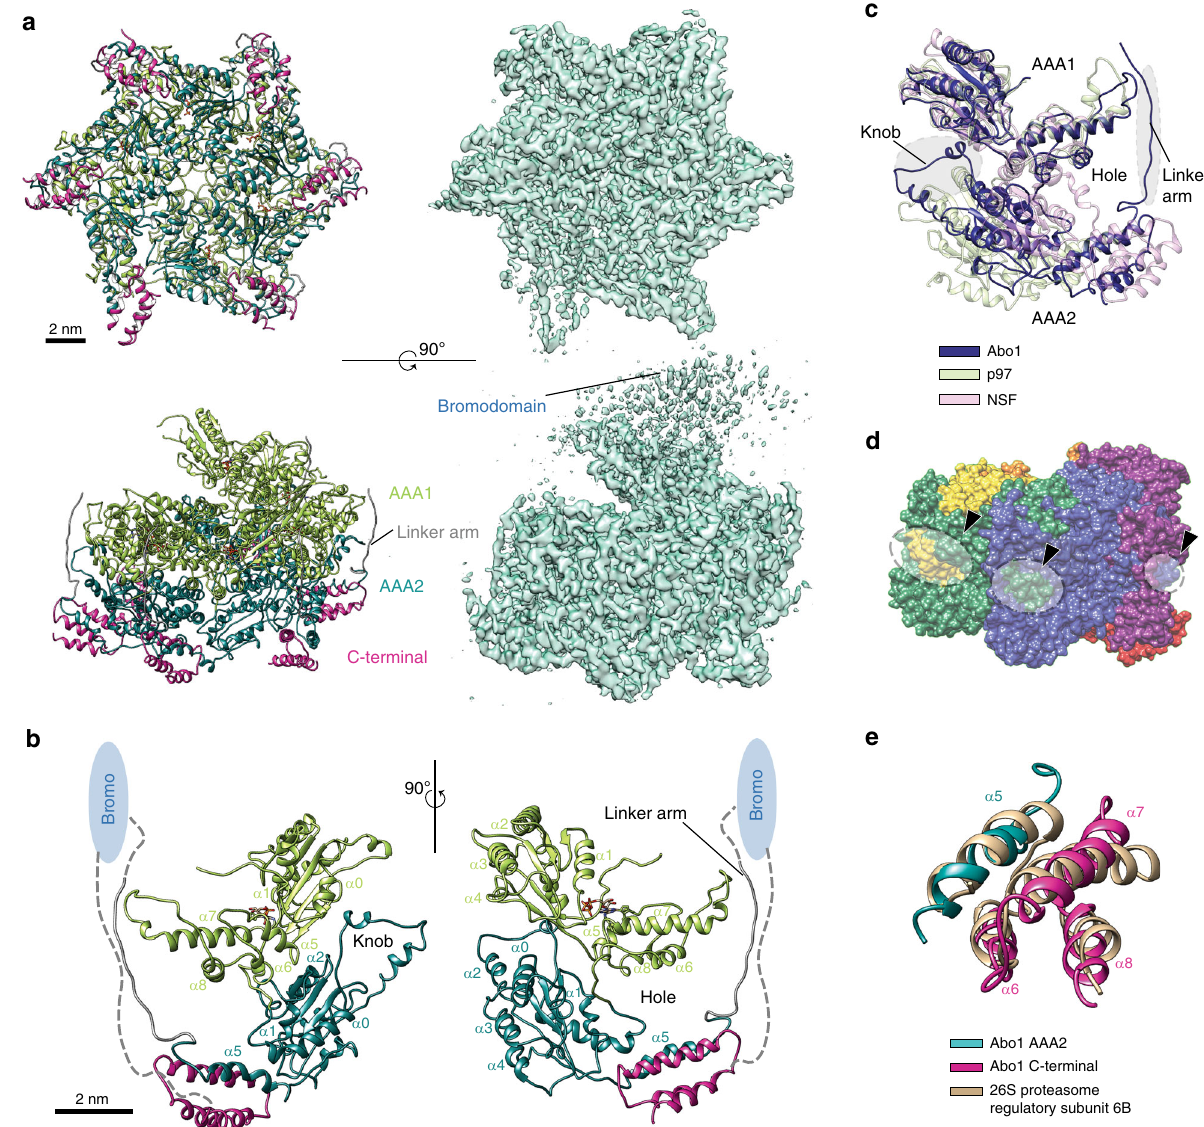
Fig. 3 Cryo-EM structure of Abo1-Walker B mutant in the ATP state shows unique AAA + structural organization. a An atomic model (left) and cryo- EM map (right) of ATP-Abo1 Walker B mutant viewed from “ bottom ” (AAA2 side, top panel) and “ side ” of the AAA + ring (bottom panel). The AAA1 domain is colored in light green, the AAA2 domain in teal, and the C-terminal domain in magenta. From the side view, the bromodomain, AAA1, AAA2, and the C-terminal form four tiers. The scale bars indicate 2 nm (20 Å). b The structure of a single Abo1 monomer within the Abo1 hexamer. Helices of AAA1 and AAA2 NBD and HBD are labeled according to AAA + structural convention. Approximate bromodomain position based on electron density maps is depicted as a cartoon oval. The connectivity of the AAA + domain, bromodomain, and C-terminal domain based on the structure and cryo-EM map is indicated as dotted lines. c Superposition of the C α ’ s of the Abo1 backbone (dark blue) with the AAA + ATPases p97 (light green, PDB ID: 5FTM) and NSF (pink, PDB ID: 3J94), aligned with respect to AAA1. The unique inserts of Abo1 — the AAA2 knob and the linker arm proceeding AAA2 α 5 — are highlighted by shaded ovals. The AAA2 domains do not align well due to the variable angle between AAA1 and AAA2. d The “ knob and hole ” packing of Abo1 subunits where the knob of one subunit inserts into the hole of the adjacent subunit (black arrowheads and dotted circles). Abo1 subunits are colored by chain. e The “ split ” AAA2 helical bundle domain (HBD) of Abo1, where α 5 of AAA2 (teal, aa 734 – 750) interacts with three helices ( α 6 – α 8) of the C-terminal domain (magenta, aa1129 – 1185). AAA2 HBD is superposed onto its closest structural relative, 26 S proteasome AAA-ATPase subunit 6B (tan, PDB ID: 5ln3), showing that the three-dimensional structure of Abo1 HBD is conserved with other AAA + HBD ’ s despite unique helix